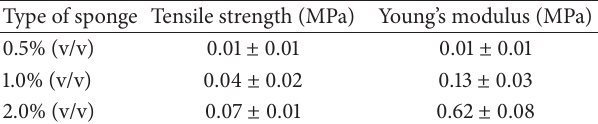
Table 3: The mechanical properties of sponge with different con- centrations of TAC under wet d